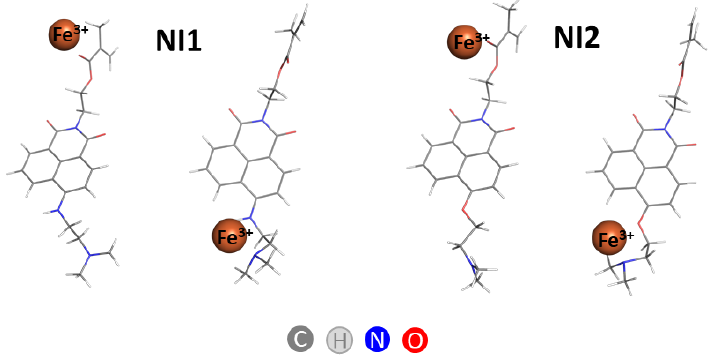
Figure 9. B3LYP optimized structures of NI1 and NI2 complexes with Fe 3+ ions.